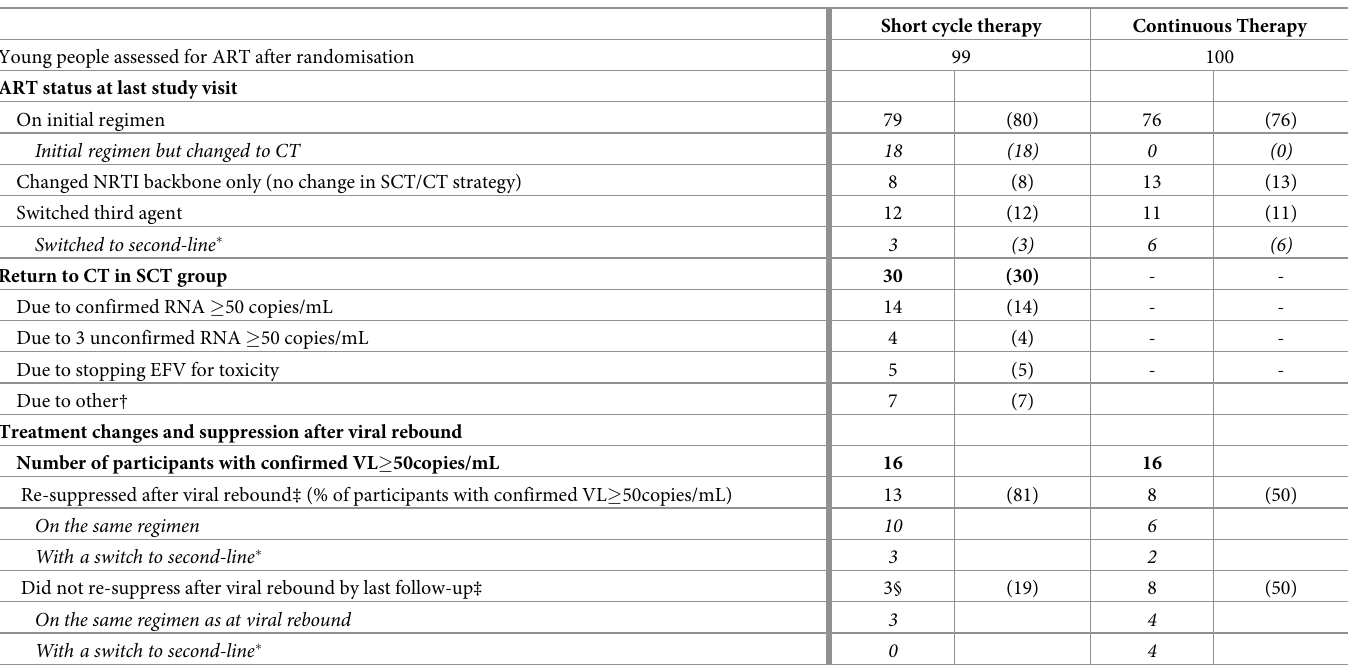
Table 3. Treatment changes and actions after viral